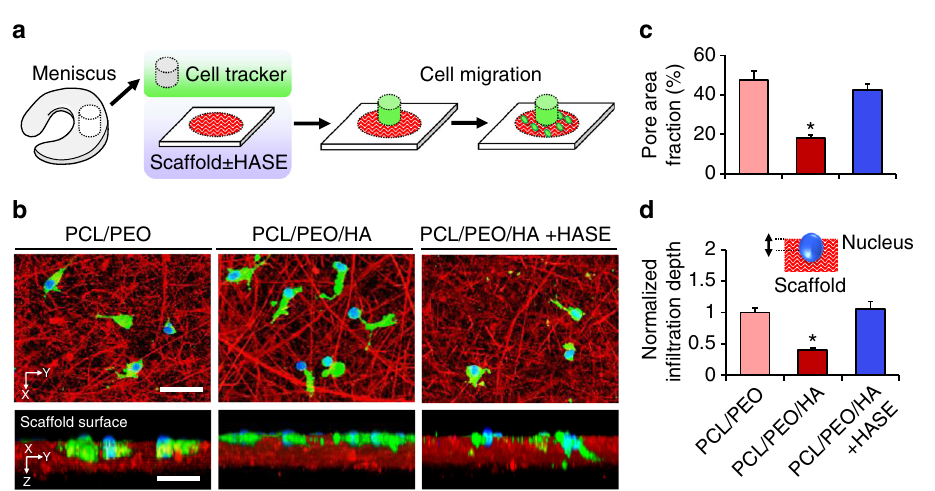
Fig. 3 High porosity scaffolds enhance cell in fi ltration. a Experimental schematic showing fl uorescently labeled tissue explant placed atop nano fi brous substrates with or without hyaluronidase (HASE) treatment. b Confocal top – down and cross-sectional views of cells (green) and corresponding nuclei (blue) within nano fi brous substrates (red). Scale = 50 µ m. c Scaffold pore area fraction ( n = 3 samples/group, mean ± s.d.). d Nuclear in fi ltration depth with schematic inset, normalized to the highly porous PCL/PEO control ( n = 20 cells/group, mean ± s.e.m.). * = p < 0.05 vs. all other